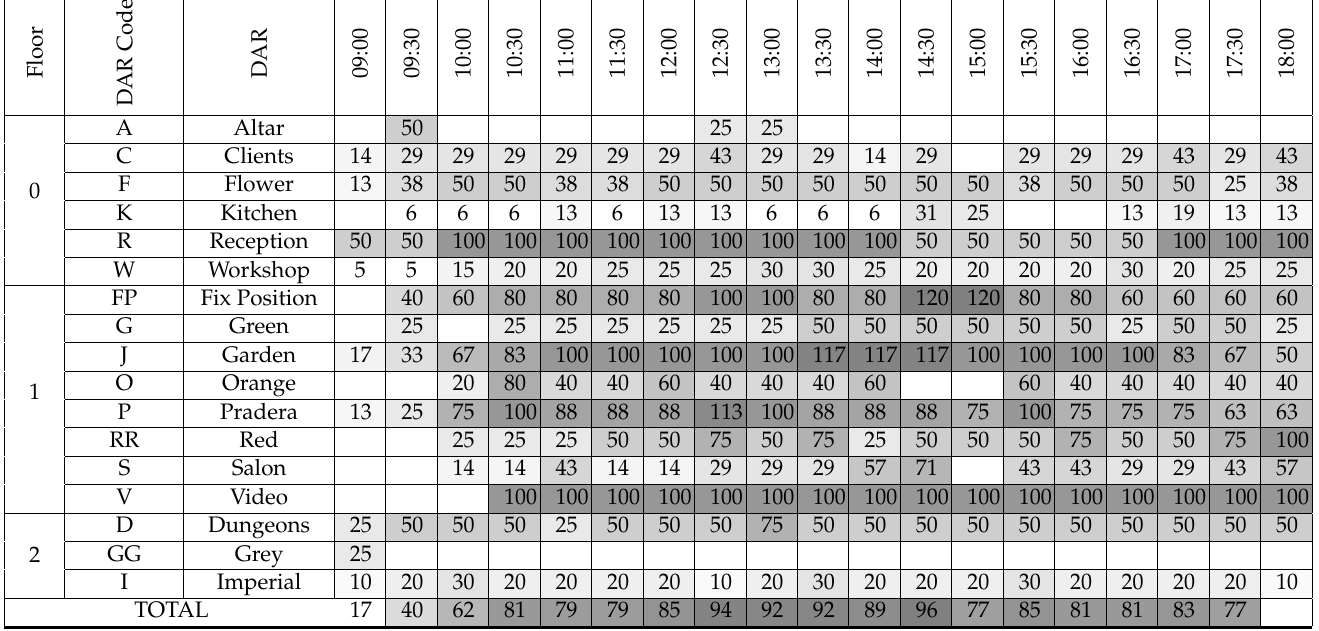
Table 7. Occupancy/capacity per DAR (measured in %). Numbers indicate the number of employees occupying each space divided by the capacity of the space, expressed as a percentage. The number of employees present at each space per hour. Dark colors highlight the areas with more users present at a